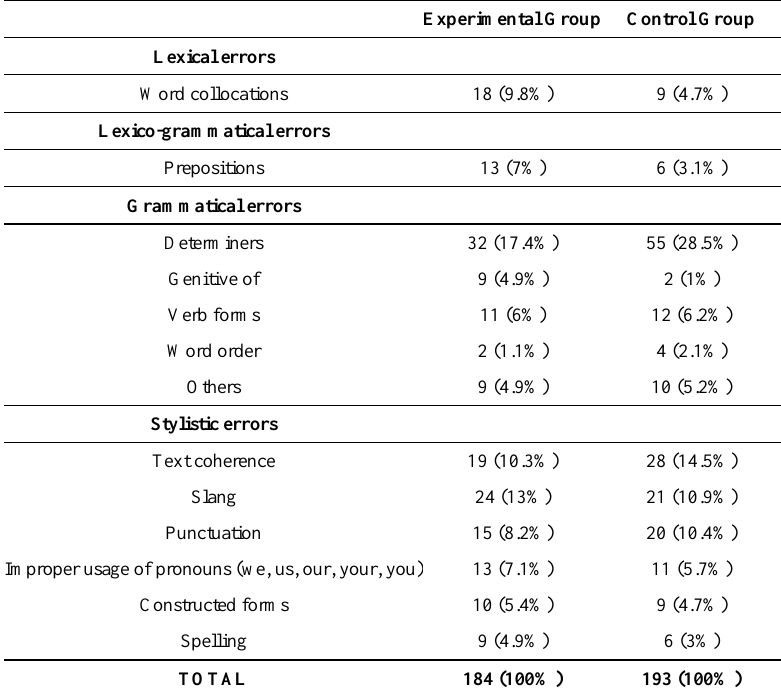
Table 2. Distribution of four major error types in